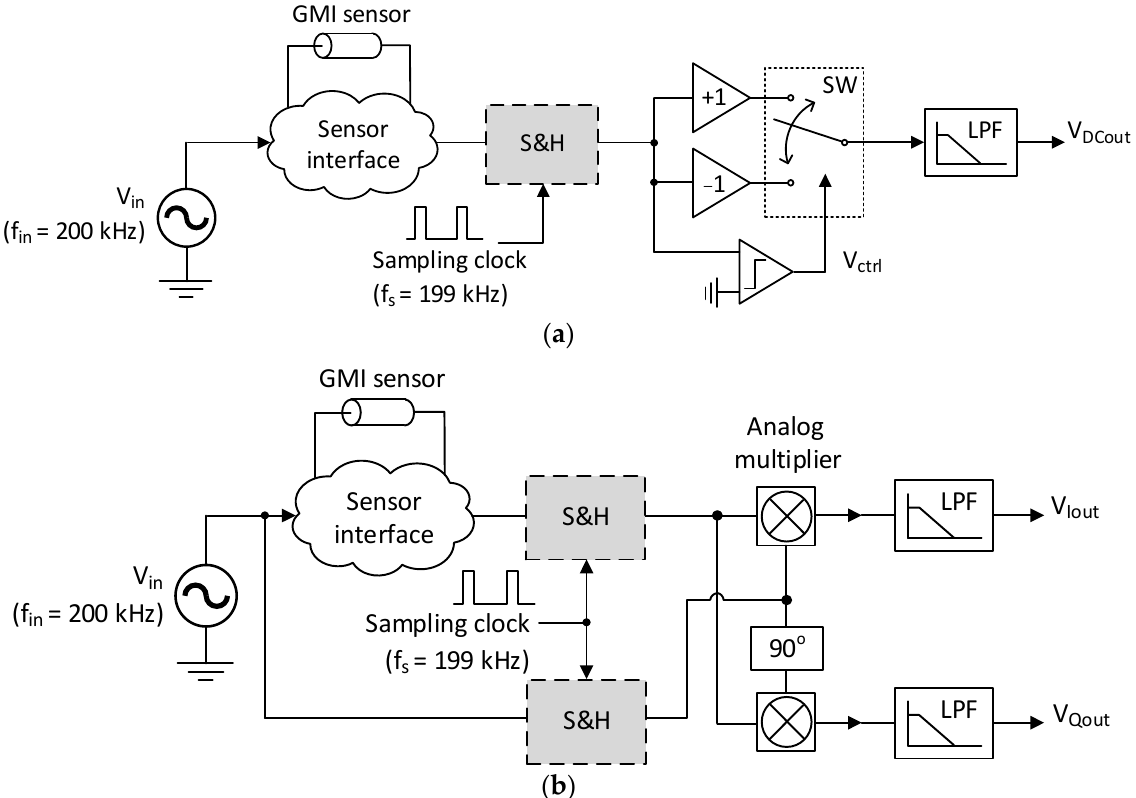
Figure 3. Block diagrams for the proposed LIA topologies using subsampling for frequency downscaling: ( a ) single-output LIA employing a switched multiplier; and ( b ) dual-output LIA using analog multipliers.